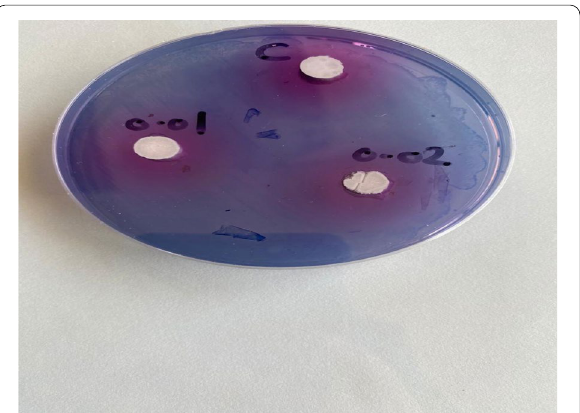
Fig. 2 Zones of inhibition after 24-h incubation